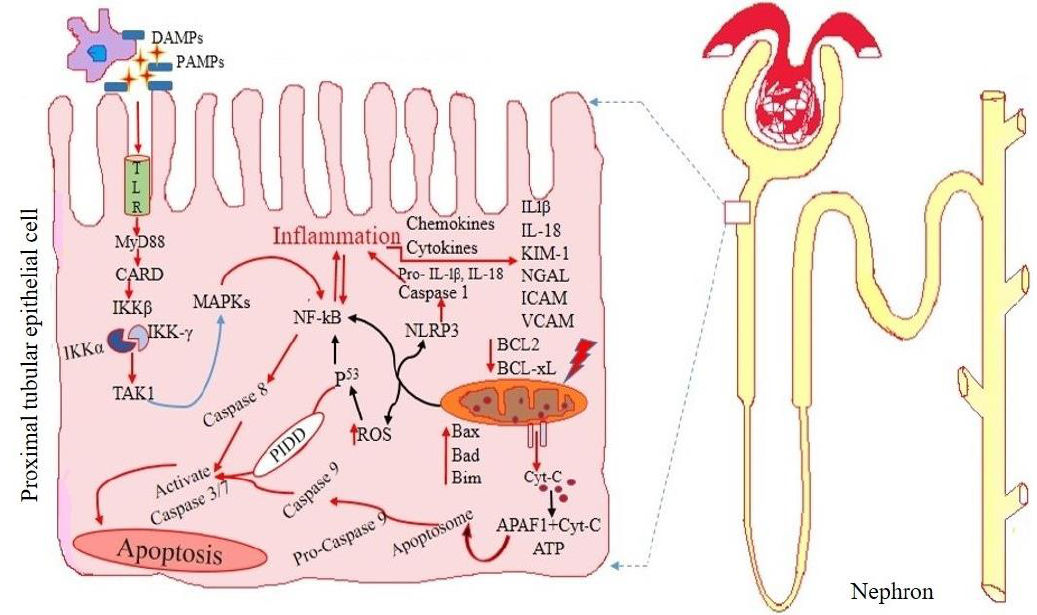
Figure 2. Drug-induced detailed mechanism of renal tubular apoptosis in acute kidney injury. Nephrotoxic drugs can cause increased oxidative stress by disrupting homeostasis mechanisms, increase free radical production and decrease the antioxidant defense system. This increases apoptosis and results in release of several biomarkers of tubular injury through urine during the early stage of kidney dysfunction.